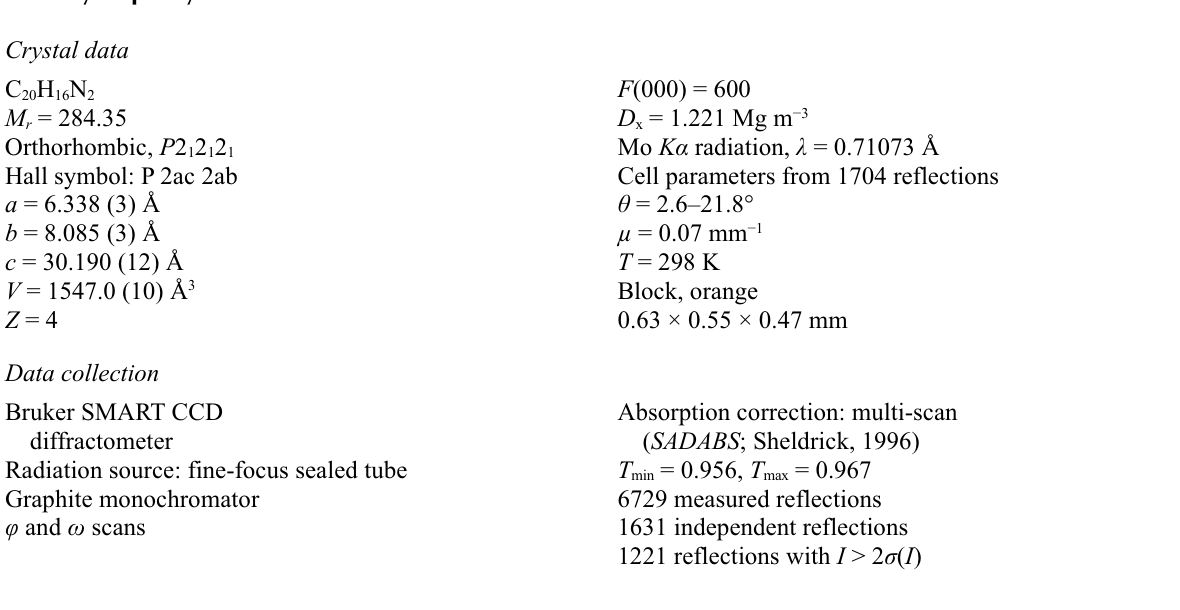
Figure 1 Molecular structure showing 30% probability displacement ellipsoids for non-H atoms. 1-Benzyl-2-phenyl-1 H